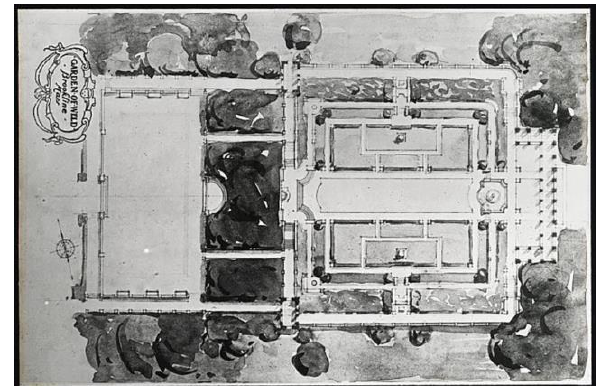
Figure 1. The main house at Weld by E.M. Wheelwright, early